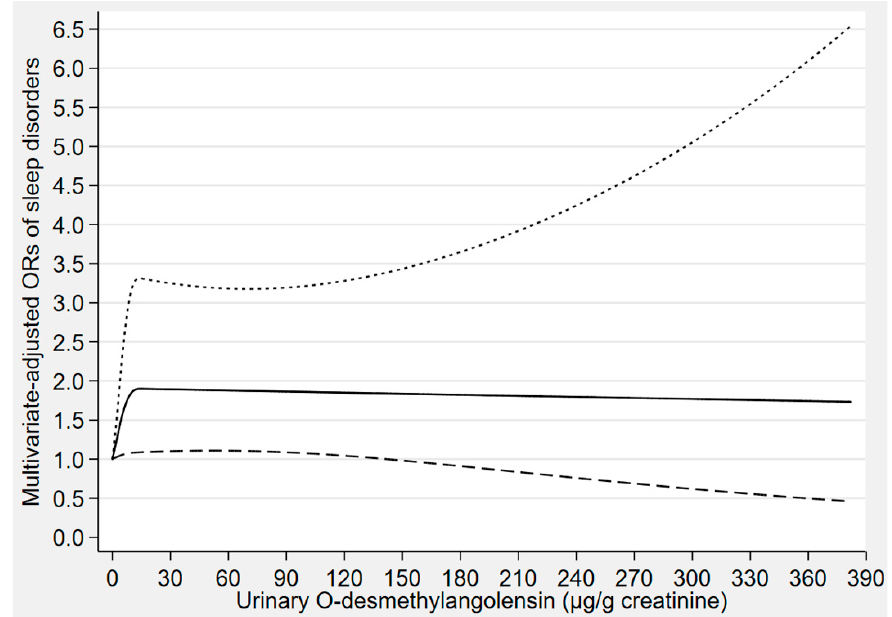
Figure 3. Concentration–response relationship of the urinary enterodiol concentration with sleep disorders. The solid line represents the estimated odds ratios (ORs) and the dashed lines represent their 95% confidence intervals. The relationship was adjusted for gender, age, marital status, race, occupation, family income, educational level, body mass index, smoking status, alcohol consumption, use of female hormones, physical activity, caffeine intake, C-reactive protein, hypertension, depressive symptoms, diabetes, and the other five phytoestrogens (tertiles).